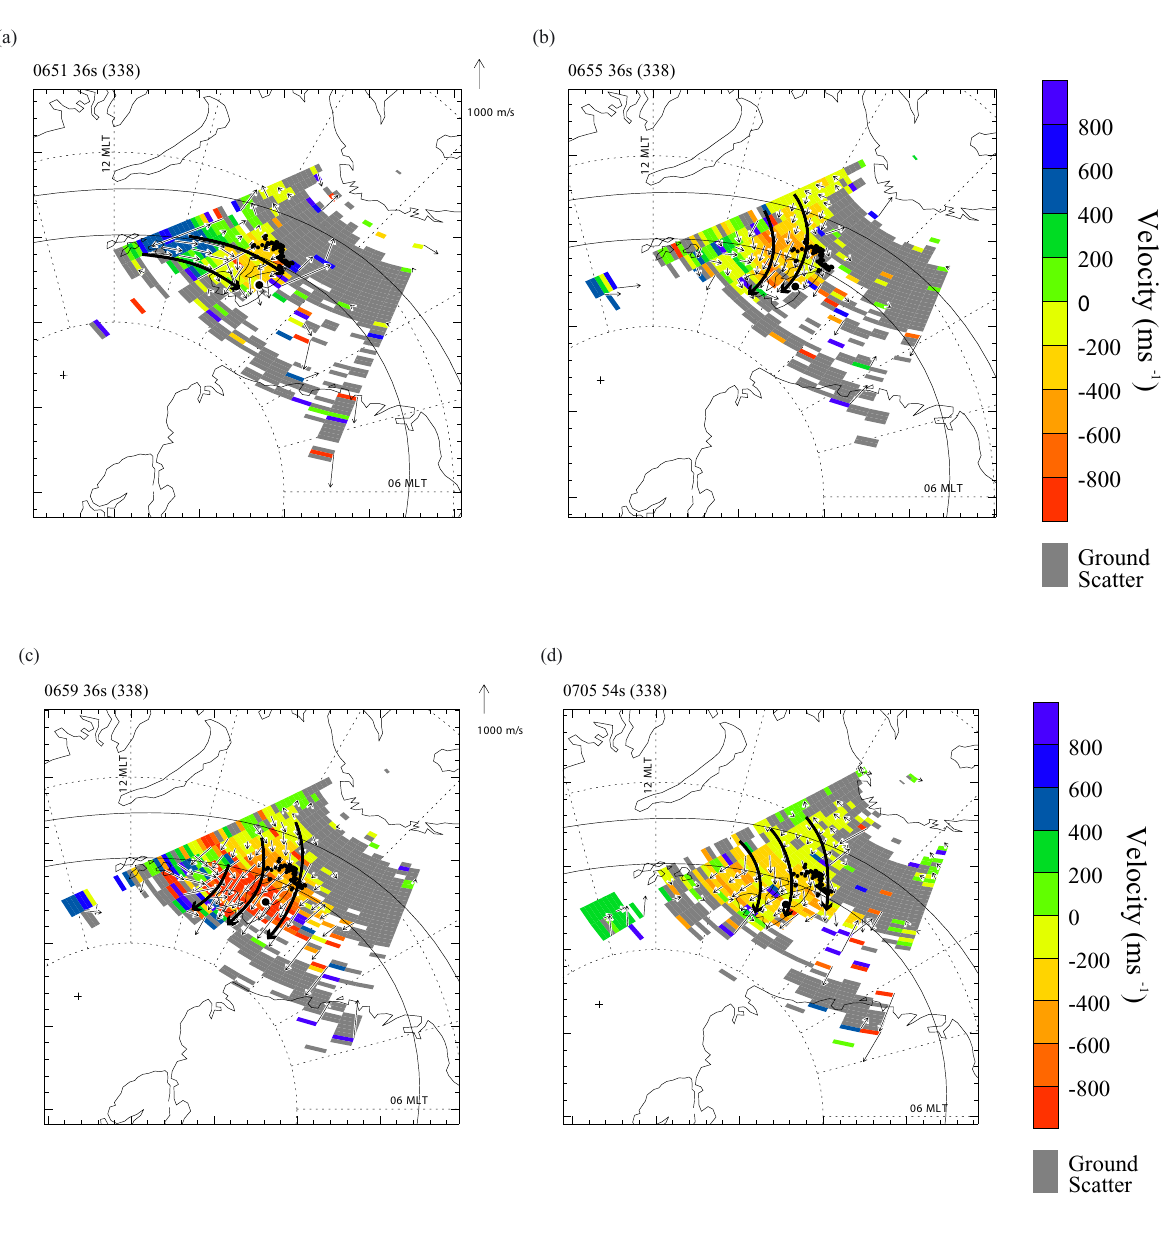
Fig. 8. Spatial maps of line-of-sight velocity measured by the CUTLASS Finland radar between 06:51UT and 07:05UT, colour-coded with negative (positive) velocities, indicating flow away from (towards) the radar. Each scan is superposed on a grid of magnetic latitude and MLT, shown by the dashed part-circles and lines. Also included is a statistical auroral oval for K p = 4. The small arrows represent convection velocity vectors derived using the beam-swinging technique of Ruohoniemi and Baker (1989); the large arrows simply highlight the direction of the overall flow over the location of the ESR, shown as a large solid dot. The collection of smaller dots ∼ 10 MLT and ∼ 73 ◦ magnetic latitude show the position of the open/closed field line boundary taken from the MSP